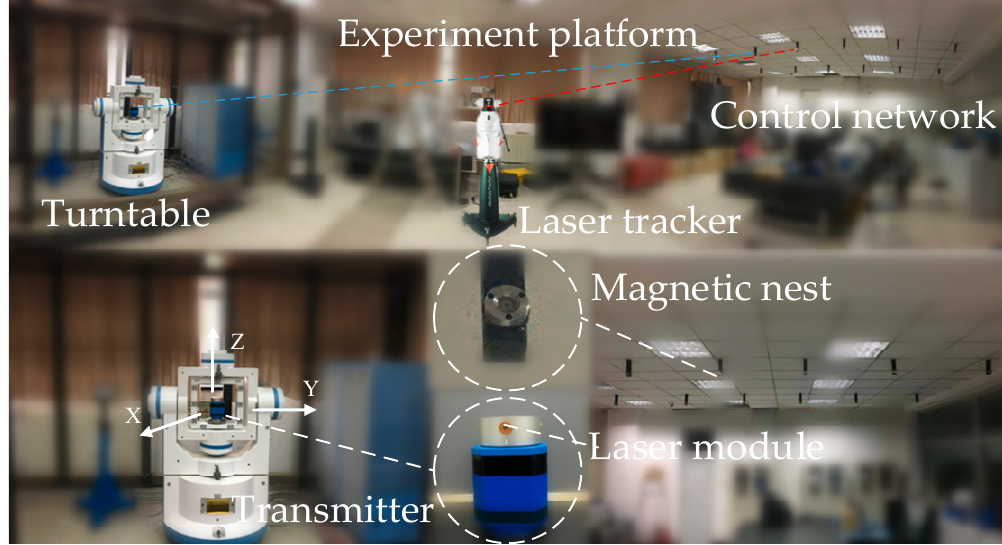
Figure 4. The experiment platform for the novel calibration method.